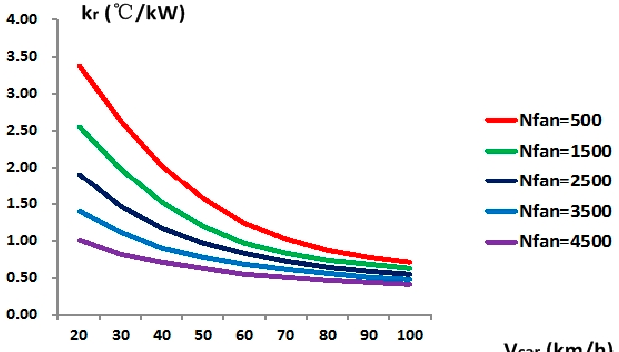
Figure 14. Coupling factor curves of the radiator.